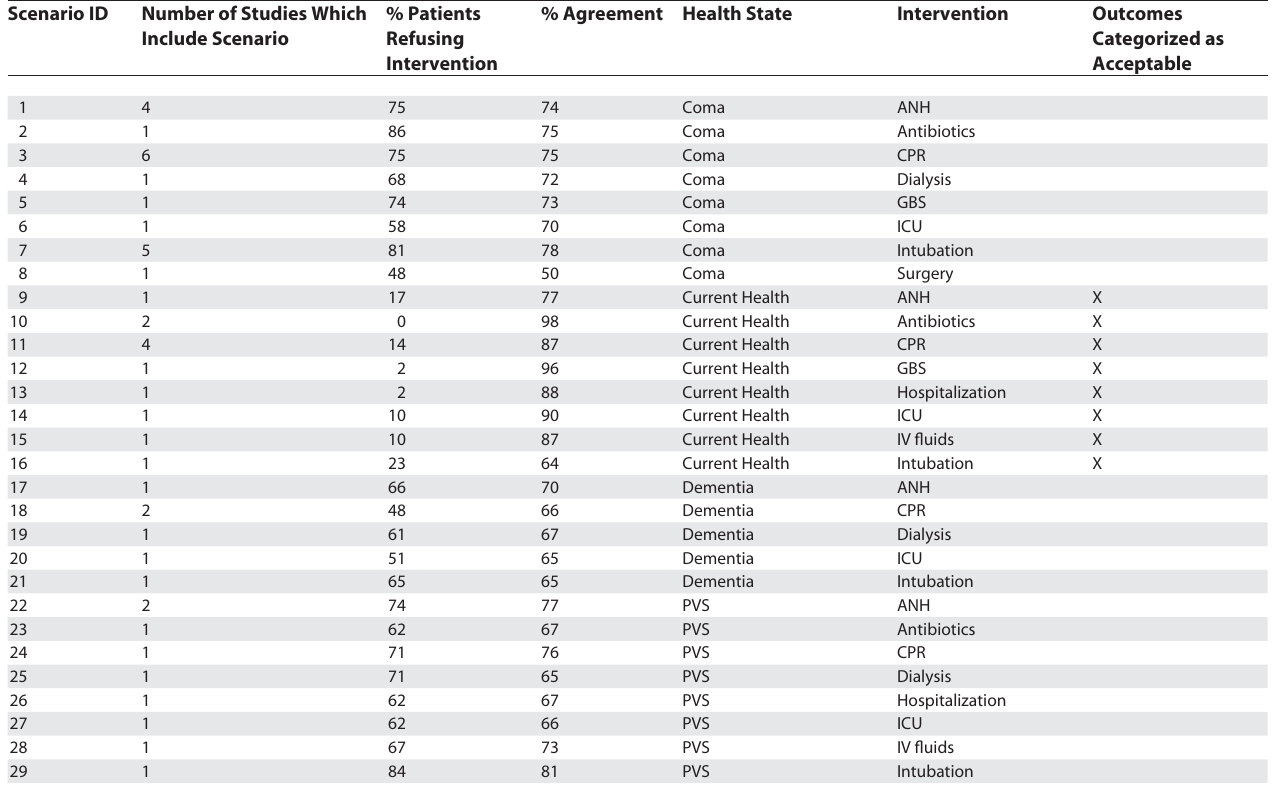
Table 1. Scenarios Included in the Surrogate/Treatment Indicator Comparison Scenario